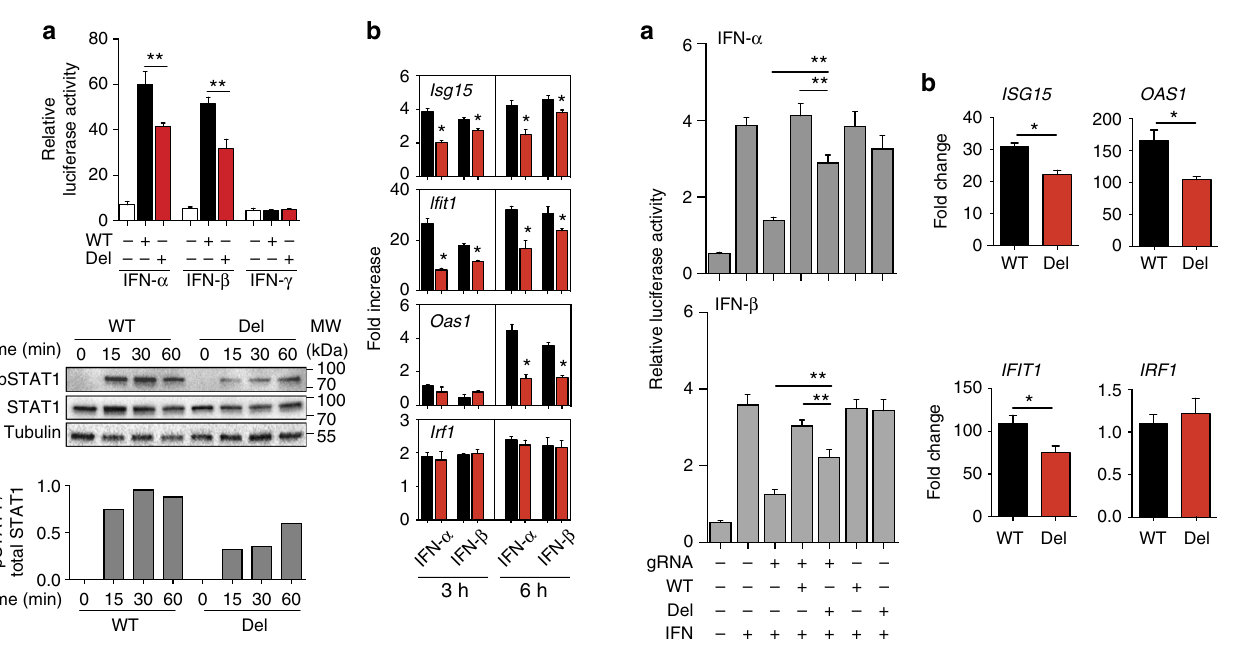
Fig. 5 TCC deletion in IFNAR1 decreases type I IFN signaling in human cells. HEK 293T cells were transfected with Cas9-expressing vector with or without endogenous IFNAR1 targeting gRNA. The endogenous IFNAR1 - silenced (gRNA+) or control (gRNA − ) cells were then transfected with WT or mutant IFNAR1 expression vectors together with an ISRE-driven luciferase reporter plasmid. a The luciferase activity was analyzed 18 h after IFN- α or IFN- β stimulation. The data shown are mean ± S.D. relative luciferase intensity units of triplicate cultures. b The expression of ISGs in WT (black) or TCC-deleted IFNAR1 (red) transfected IFNAR1 knockout HEK293 cells at 6 h after stimulation with IFN- β determined using qRT- PCR. The data shown are mean fold increase ± S.D. (triplicate cultures) over unstimulated controls. Data shown are representative of 2 –